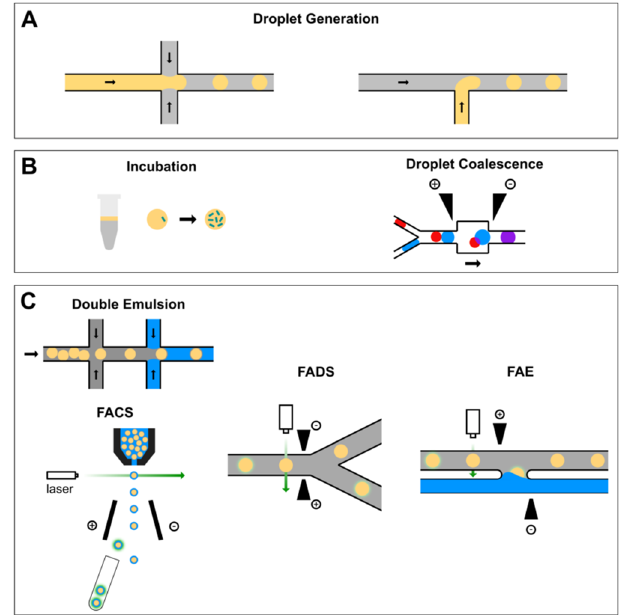
Figure 1. A typical workflow of droplet-based high-throughput screening system for protein engineering. ( A ) Single cells are encapsulated into monodisperse water-in-oil droplets generated on a flow-focusing (left) or T-junction (right) nozzle. ( B ) Cell-laden droplets can be incubated either on-chip or off-chip and new reagents can be added via droplet coalescence. ( C ) Droplets of interest can be sorted either by fluorescence-activated cell sorting (FACS) after an extra step of double emulsification or by fluorescence-activated droplet sorting (FADS). Alternatively, the content of droplets of interest can be recovered via fluorescence-activated electrocoalescence (FAE).